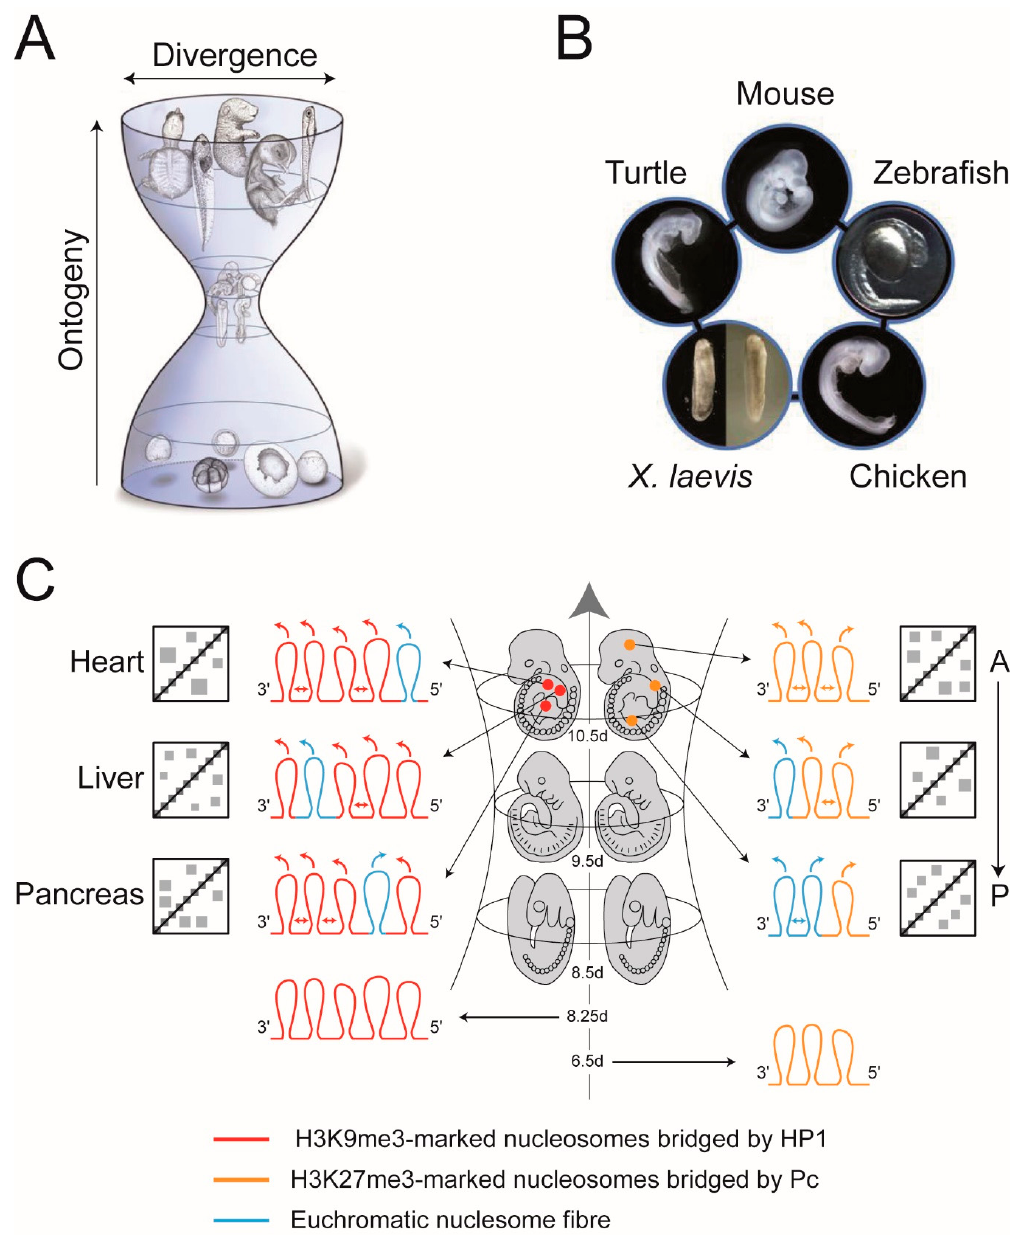
Figure 4. The phylotypic progression of vertebrate development and the generation of cell-type- and position-specific contact enrichments that contribute to epigenetic compartmental domains (ECDs). ( A ) The developmental hourglass model for vertebrate development. The model predicts that the mid-embryonic organogenesis stages (phylotypic progression) represent the developmental stages with highest morphological conservation across vertebrates. The phylotypic progression encompasses the developmental window when the anterior-posterior axis (body plan, Bauplan ) is laid down. By the end of the phylotypic progression cell-type-specific patterns of gene expression have been initiated and position-specific ( Hox code) patterns of gene expression are established and thereafter maintained for the rest of development. Taken and modified from [140]. ( B ) The phylotypic progression for vertebrates. This figure is taken from [140] where two stages of Xenopus laevis were shown because there was no statistically significant difference between these two stages. ( C ) Establishment of cell-type- and position-specific contact enrichments that contribute to ECDs. Depicted in the middle